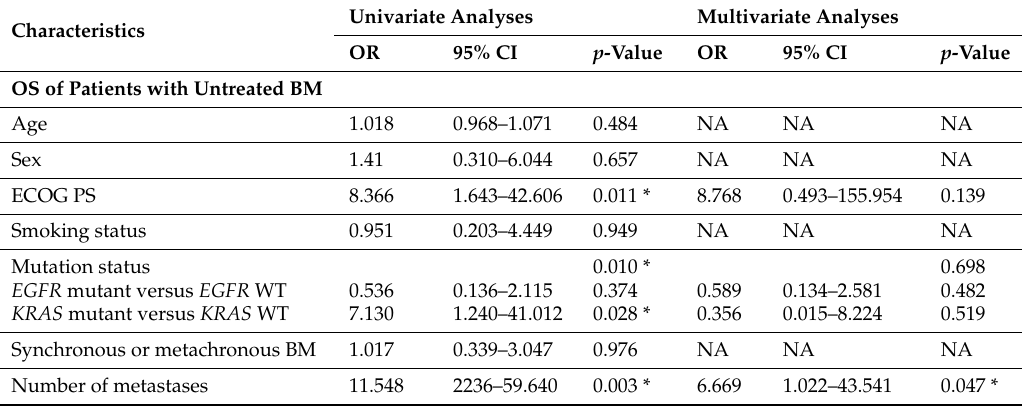
Table 5. Univariate and multivariate analyses of overall survival in patients with untreated brain metastasis. OR: odds ratio; 95% CI: 95% confidence interval; BM: brain metastasis; age: <65 versus ≥ 65; sex female versus male; ethnicity: Caucasian versus non-Caucasian; smoking status: smoker versus nonsmoker; primary tumor local treatment: surgery or radiation therapy versus no local treatment; Mutation status: EGFR mutant versus KRAS mutant versus KRAS and EGFR wild type tumors; WT: wild-type; number of metastases: one metastasis versus several metastases; *: significant p